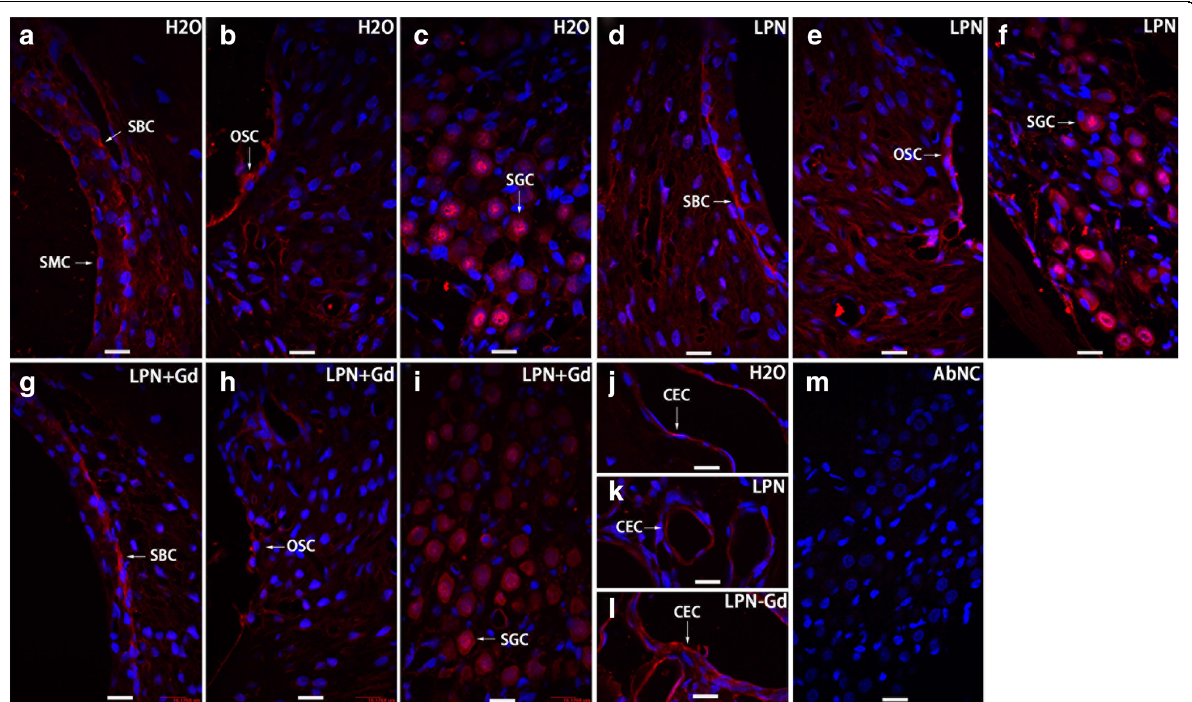
Fig. 7 Hyaluronic acid secretion in rat cochlea exposed to liposome nanocarriers was detected with immunofluorescent confocal microscopy. Positive staining was found in the stria basal cell ( SBC ), outer sulcus cell ( OSC ), spiral ganglion cell ( SGC ), and capillary endothelial cell ( CEC ) of modiolus of groups of negative control ( H2O ) ( a – c , j ), empty liposome nanocarriers ( LPN ) ( d – f , k ), and Gd-DOTA-containing LPN ( LPN+Gd ) ( g – i , l ). There was no staining in the antibody omitted negative control ( AbNC ) ( m ). CEC capillary endothelial cell, ISC inner sulcus cell, SBC stria basal cell, SL-I spiral ligament fibrocyte type I, SLSF spiral limbus satellite fibrocyte, SMC stria vascularis marginal cell. Scale bar =16 μ m